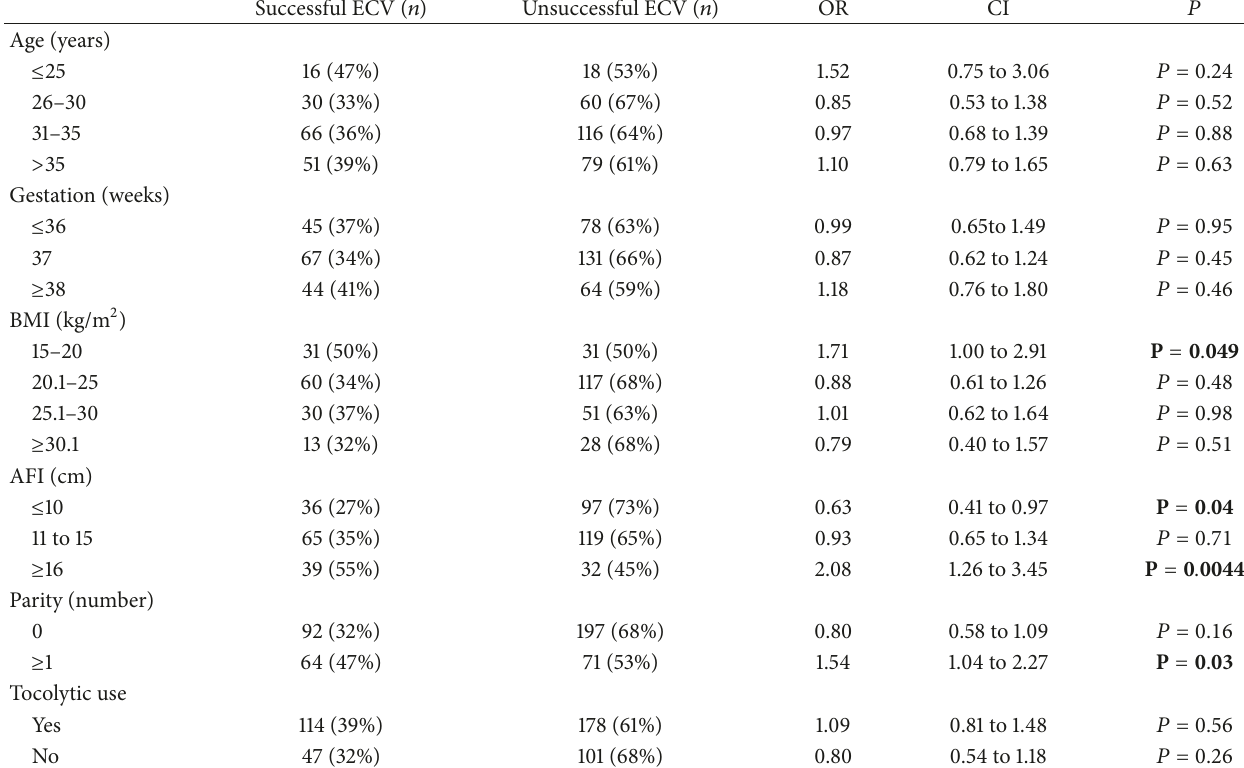
Table 2: Predictors of ECV